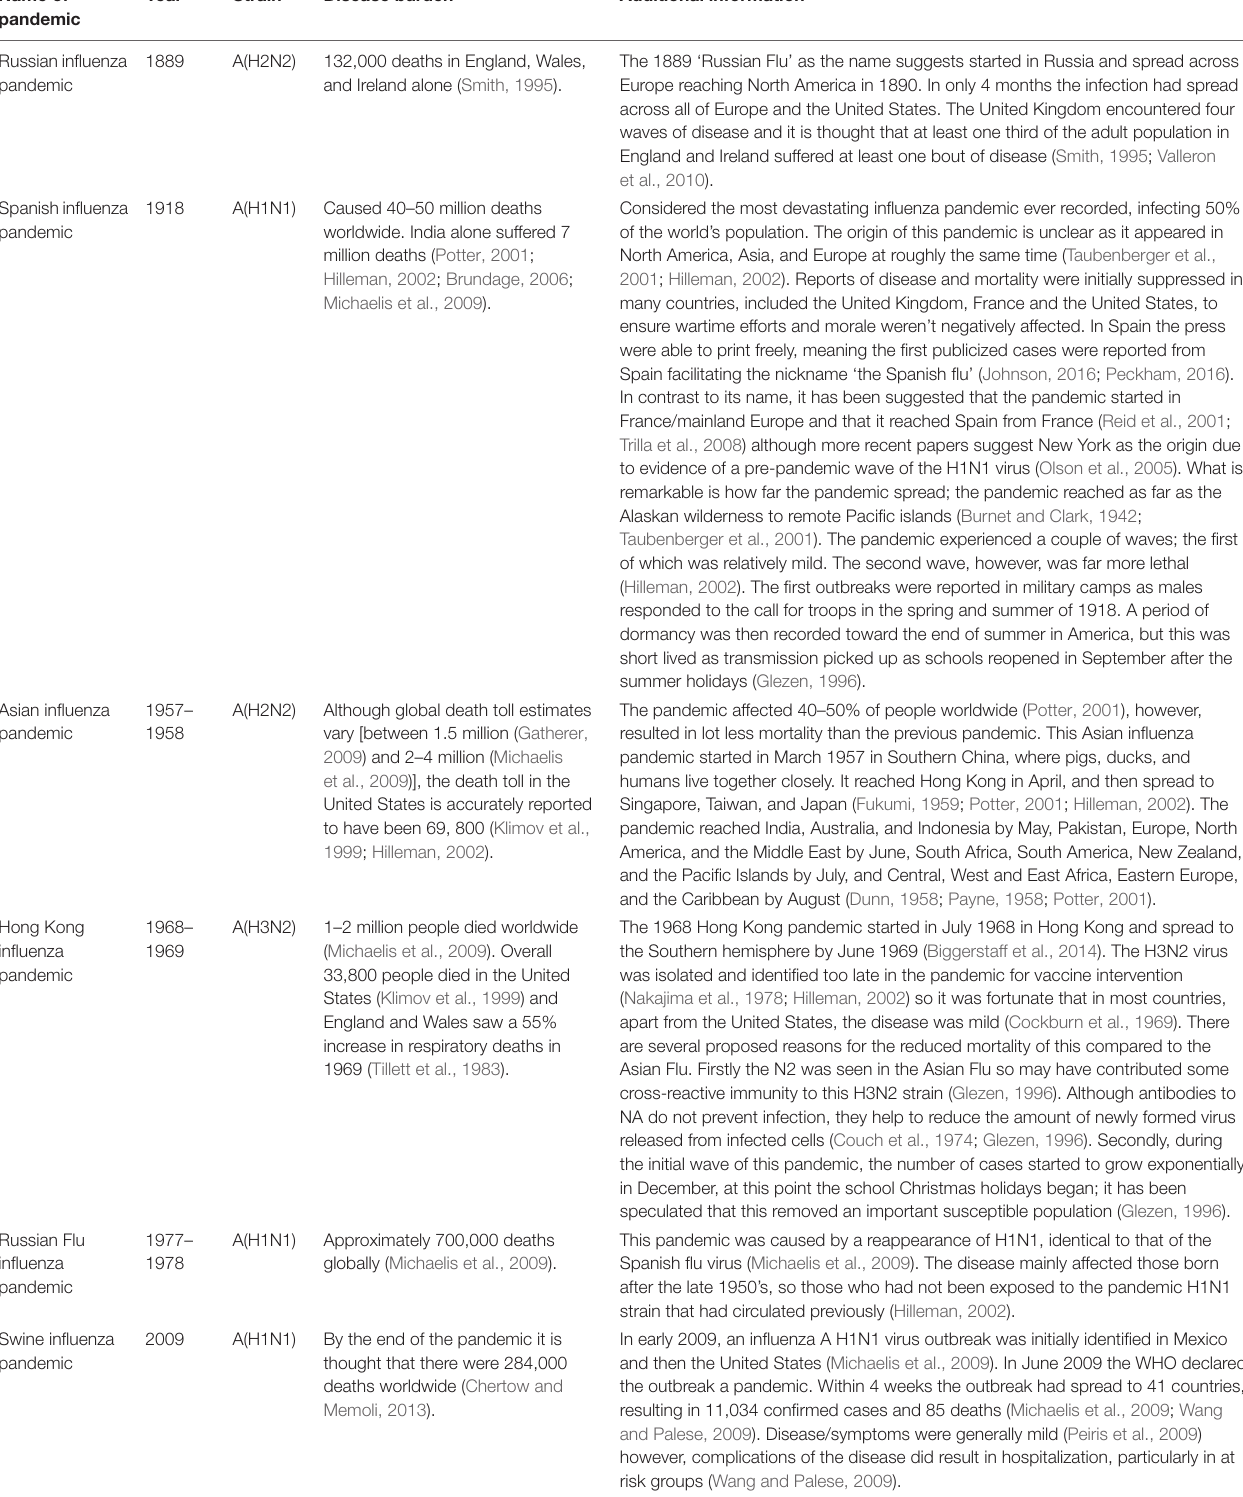
TABLE 1 | Details of significant influenza pandemics since the late